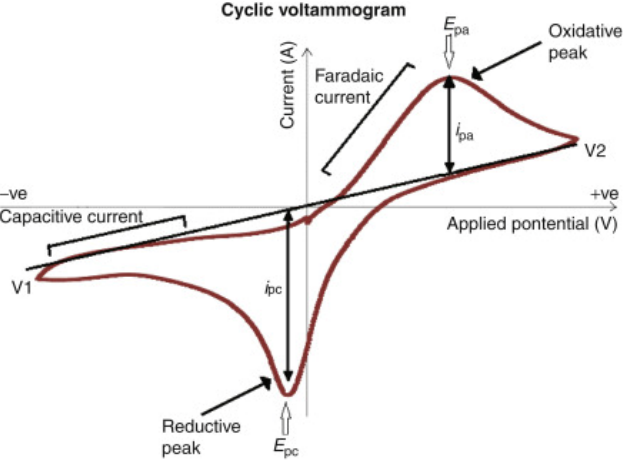
Figure 5. A schematic diagram of a cyclic voltammogram according to the IUPAC convention: peak cathodic potential (E pc ), peak anodic potential (E pa ), difference between the cathodic current and the resting current (i pc ) and difference between the anodic current and the resting current (i pa ) [52].